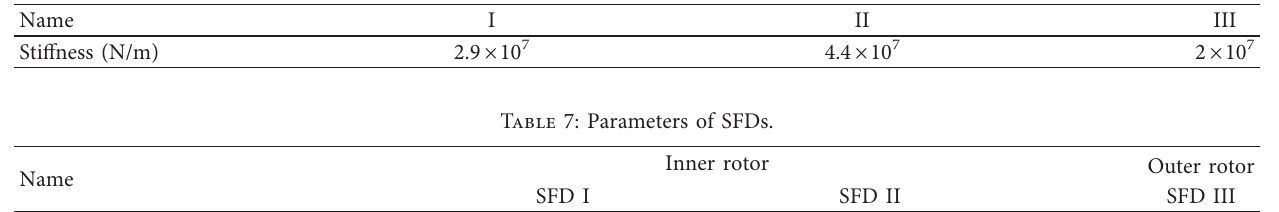
Table 6: Radial stiffness of elastic supports.